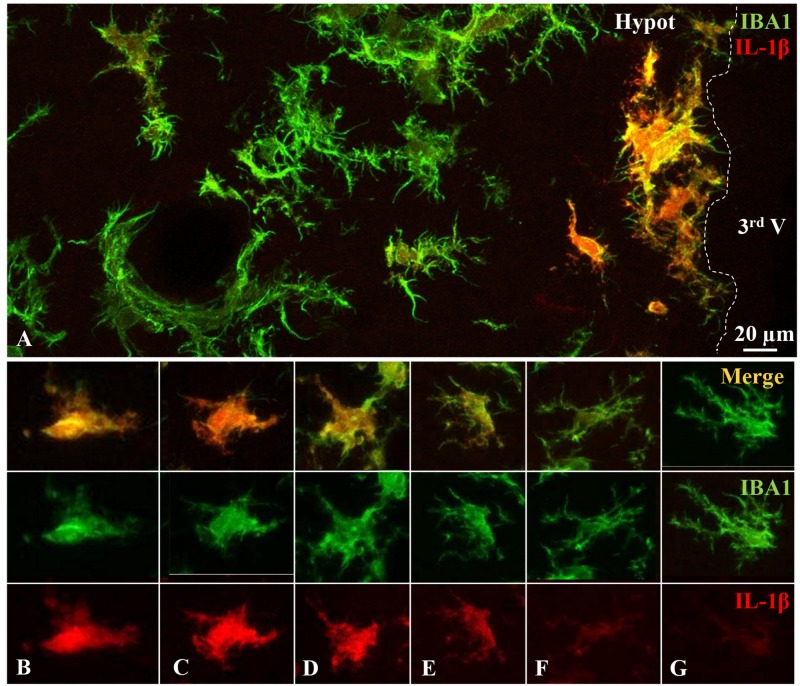
Varied expression level of the inflammatory cytokine IL-1β by hypothalamic microglial cells. Double immunofluorescence staining on brain sections obtained from rats ICV-injected with NA. Twelve hours after NA-injection, a broad co-localization of IL-1β (red) in IBA-1 positive (green) hypothalamic cells can be observed (A). In sub-ependymal and periventricular areas, microglial cells similarly stained with IBA1 displayed diverse IL-1β staining intensities, which ranged from high (B,C), or medium (D,E) to low (F,G). Hypot, hypothalamus; 3rd V, third ventricle.